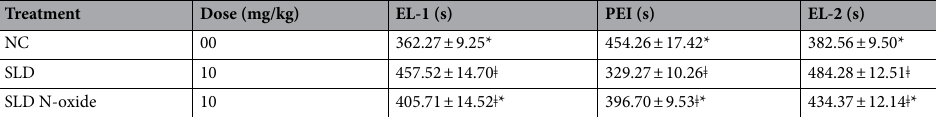
Table 8. Effect of SLD and SLD N-oxide on ejaculation latency in 1st and 2nd series and post ejaculatory interval of male rats (n = 6). ǂ Indicate significance in comparison to NC group at p < 0.05. *Indicate significance in comparison to SLD group at p <